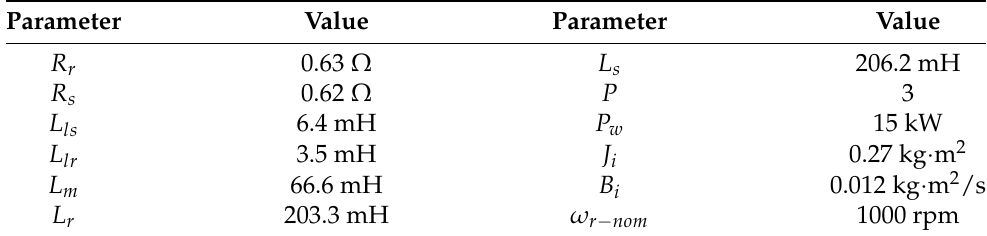
Table 1. Electrical and mechanical parameters of the six-phase IM